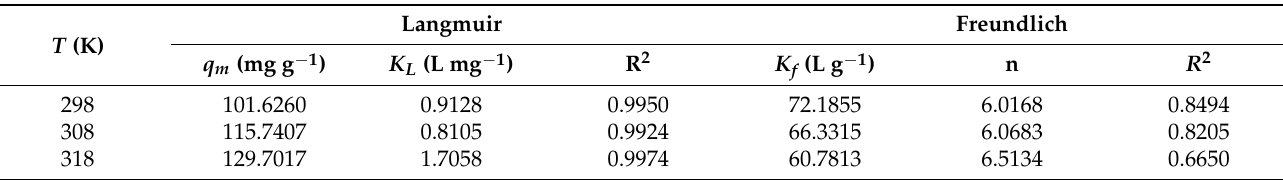
Table 4. Fitted parameters of the Langmuir and Freundlich model.